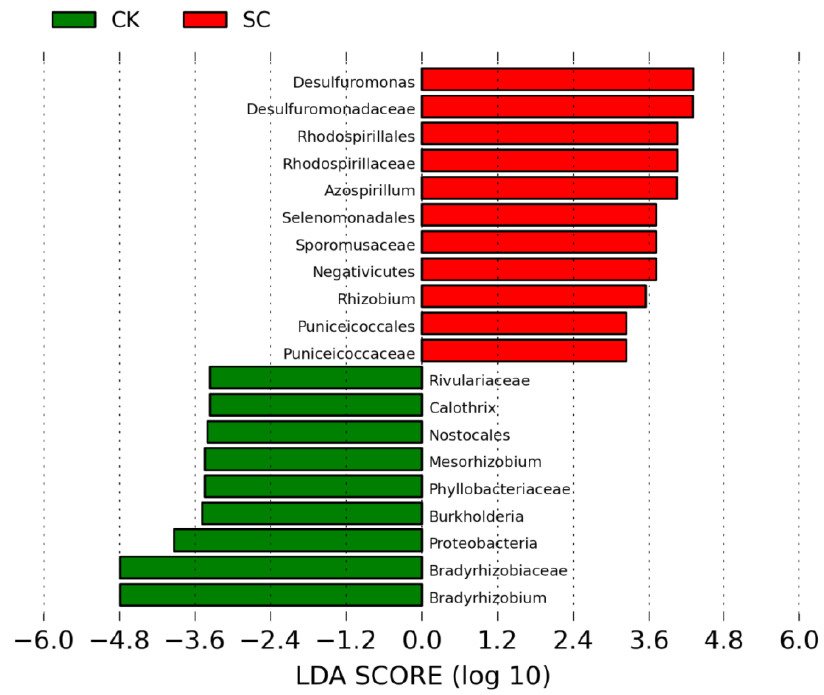
Figure 2. LEfSe method identifies the significantly different abundant taxa of diazotrophs in SC and CK. Abbreviations: SC, grasslands invaded by S. chamaejasme ; CK, uninvaded grasslands.